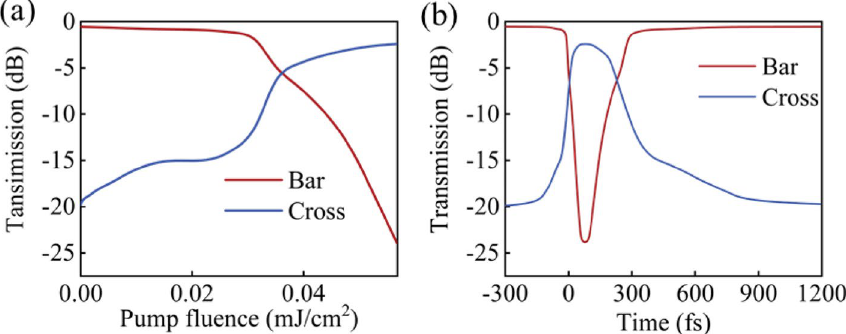
Figure 7. ( a ) Transmission versus pump fluence at the output Bar and Cross port. ( b ) Transient transmission at the output Bar and Cross